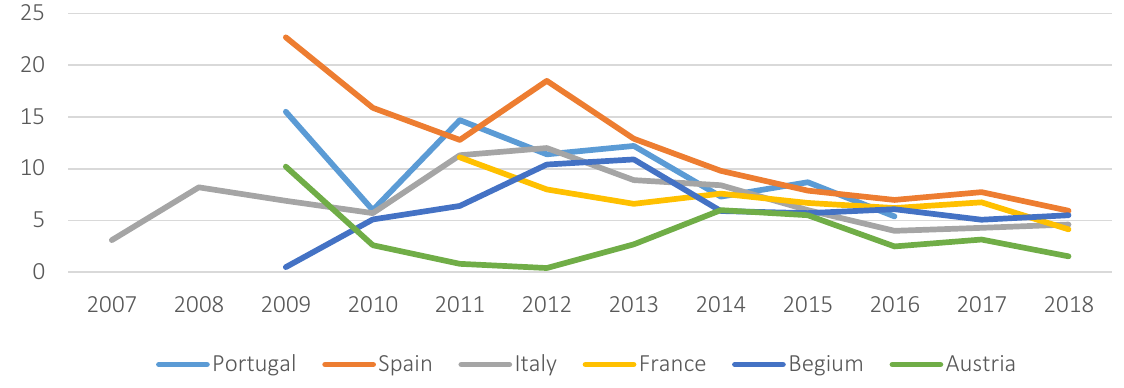
Figure 2. SME loan rejection rates from 2007 to